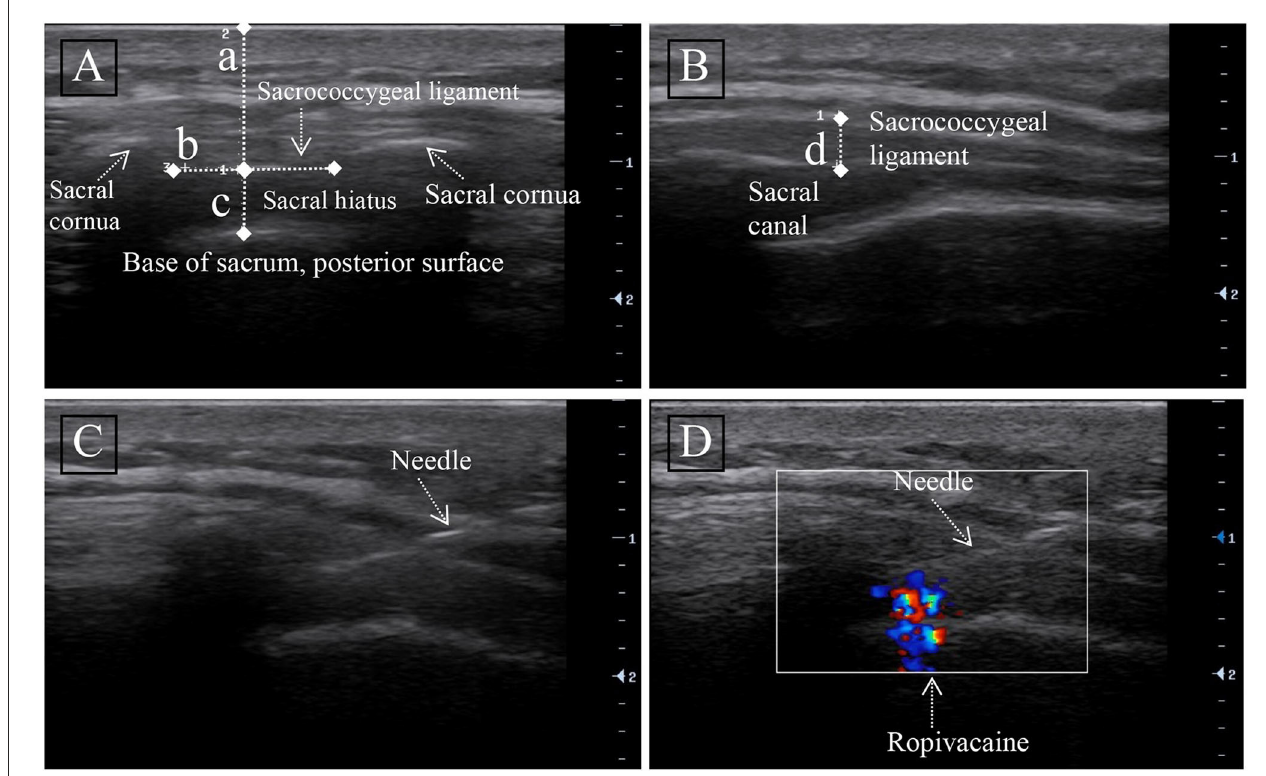
FIGURE1 Ultrasound image of the sacral canal. (A) Transversal ultrasound image of the sacral canal. (B) Longitudinal ultrasound image of the sacral canal. Measurement of the distance from the anterior edge of the sacrococcygeal ligament (SL) to the sacrum (line c), skin to the anterior edge of sacral ligament distance (line a), sacrococcygeal ligament width (b), and thickness (line d) were done. (C) Longitudinal ultrasound image of the needle in the sacral canal. (D) Unidirectional flow on color Doppler showing the injection of ropivacaine into the sacral